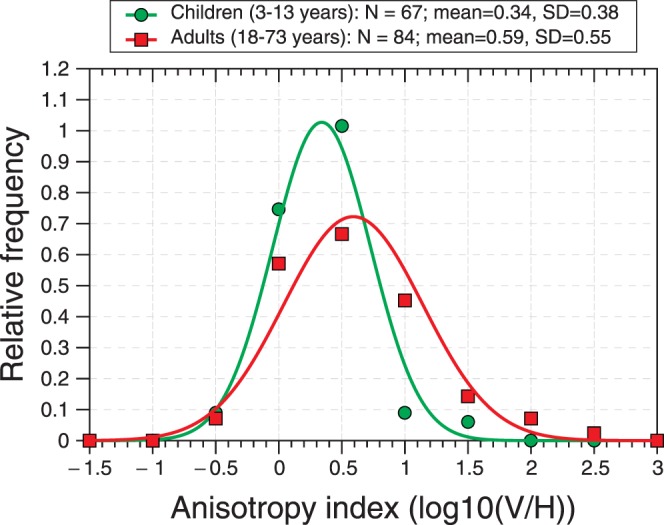
Distribution of stereo anisotropy index in children (green circles, N = 67) and adults (red squares, N = 84), from the data in Figure 5. Symbols show the frequency histogram; curves are Gaussians with the mean and SD of the anisotropy index for that age group.